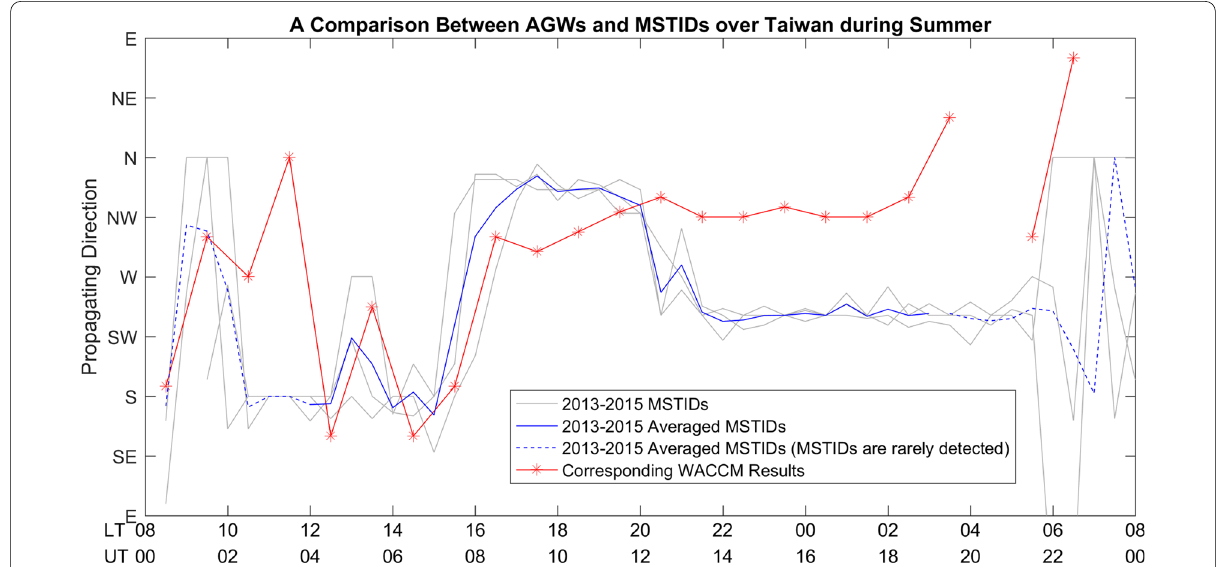
Fig. 11 Comparison between the propagation directions of MSTIDs and the AGWs derived from WACCM. The gray lines are the MSTID propagation direction during 2013–2015, and the blue line represents the averaged value during 2013–2015, while the dashed line indicates the MSTIDs are rarely detected. The red line with stars displays the corresponding WACCM